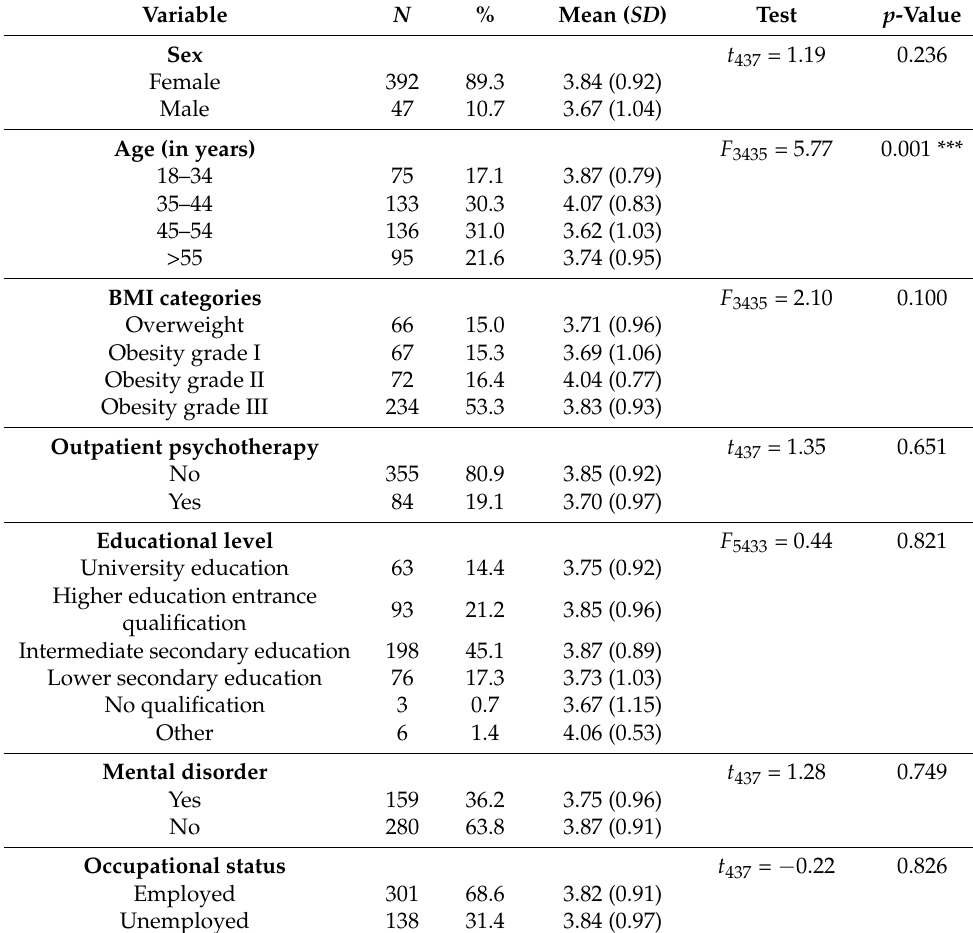
Table 2. Differences in acceptance (UTAUT behavioral intention scale) by sociodemographic and medical